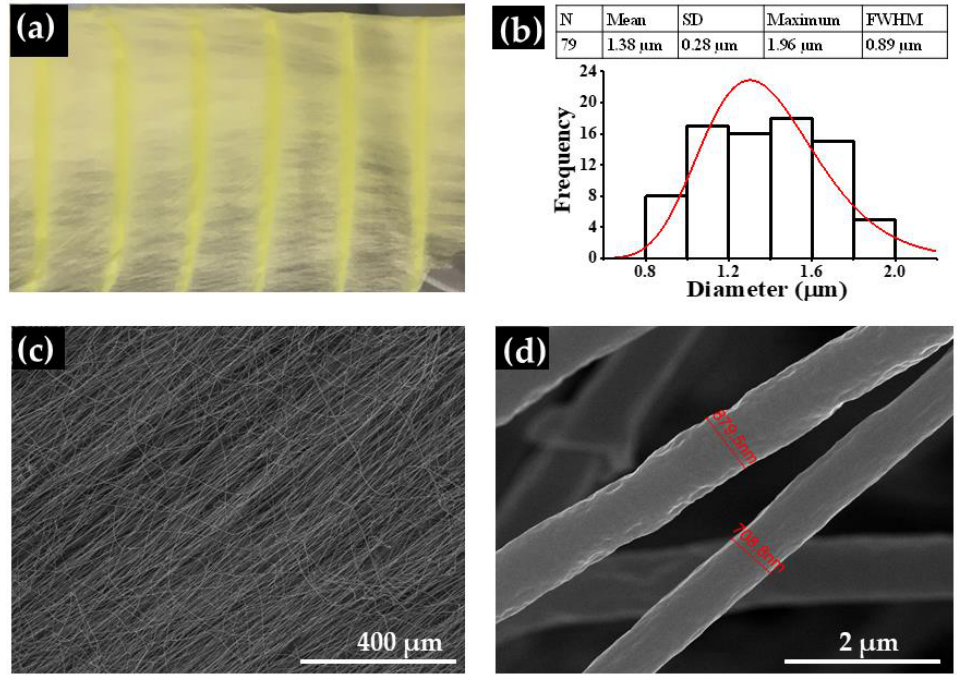
Figure 1. ( a ) Electrospun NNDM4NA@PLLA microfiber array as collected on a rotatory drum; ( b ) microfiber diameter distributions with average fiber diameters (mean), standard deviation (SD) and full width at half maximum (FWHM); SEM images at 250× ( c ) and 50,000× ( d ) magnification level. The fiber diameter distribution was fit to a log-normal function.